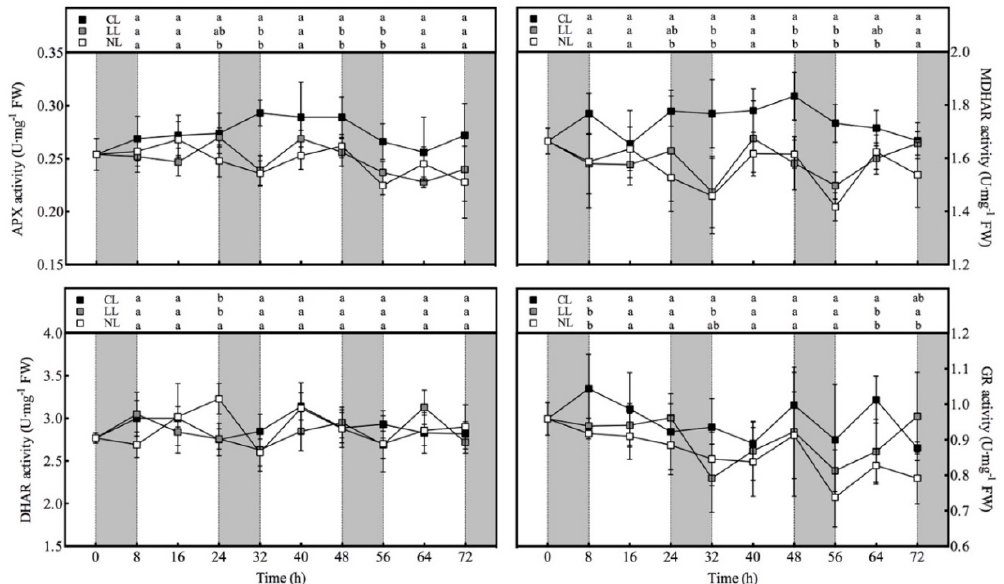
Figure 3. Effects of light intensities at night time on the activities of APX, MDHAR, DHAR, and GR in lettuce leaves under red and blue continuous light.